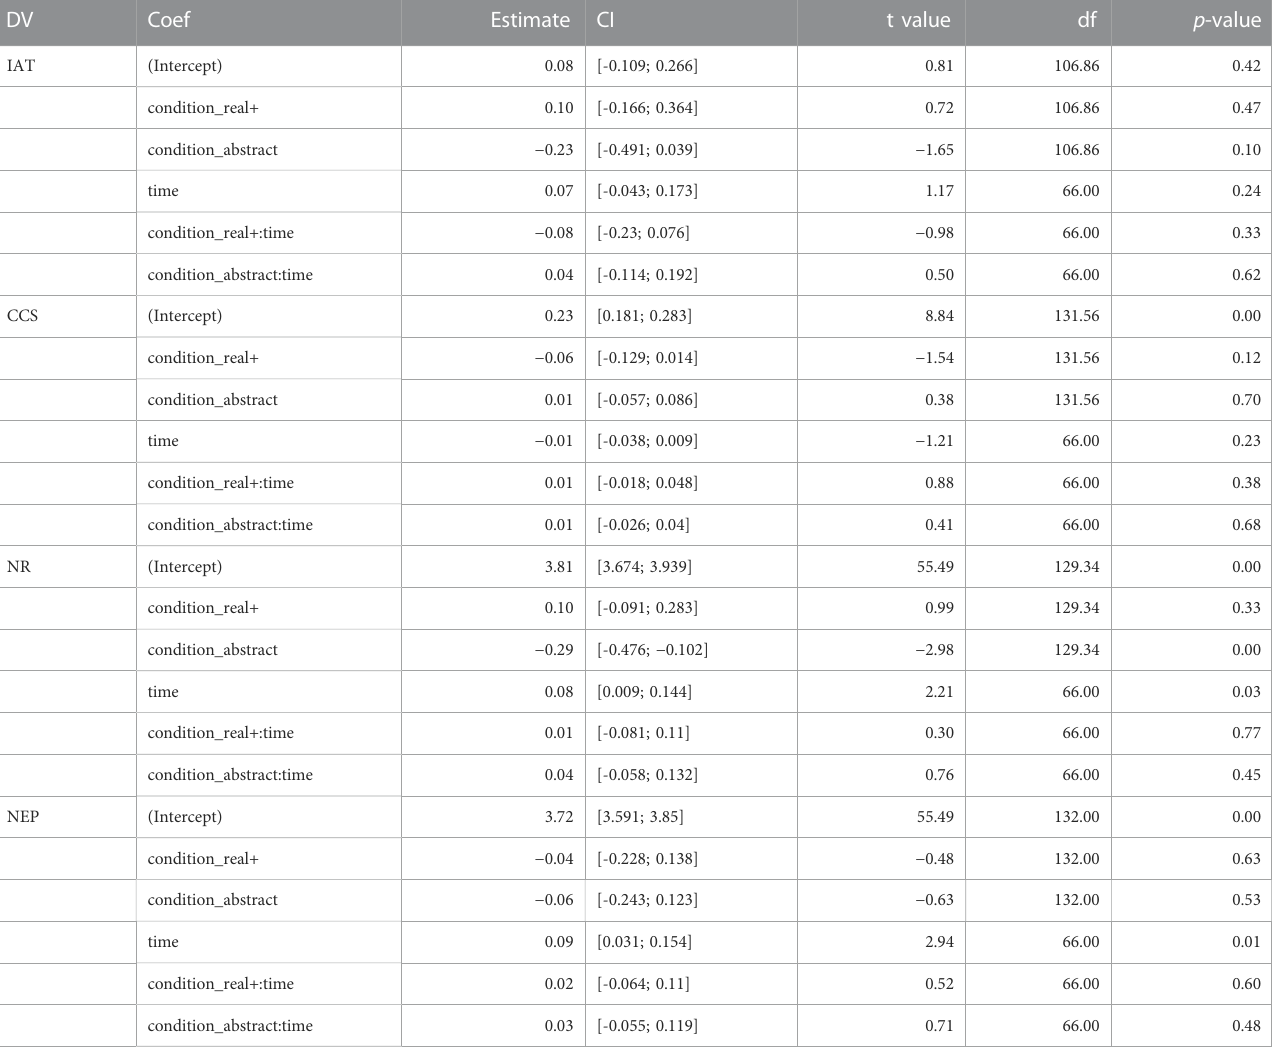
TABLE3ModelscomparingthethreeVRconditions.Conditionisdeviationcoded,i.e.thecoef fi cientcondition_real+representsthedifferencebetweentherealisticVR condition compared to the average value over all three conditions at the fi rst